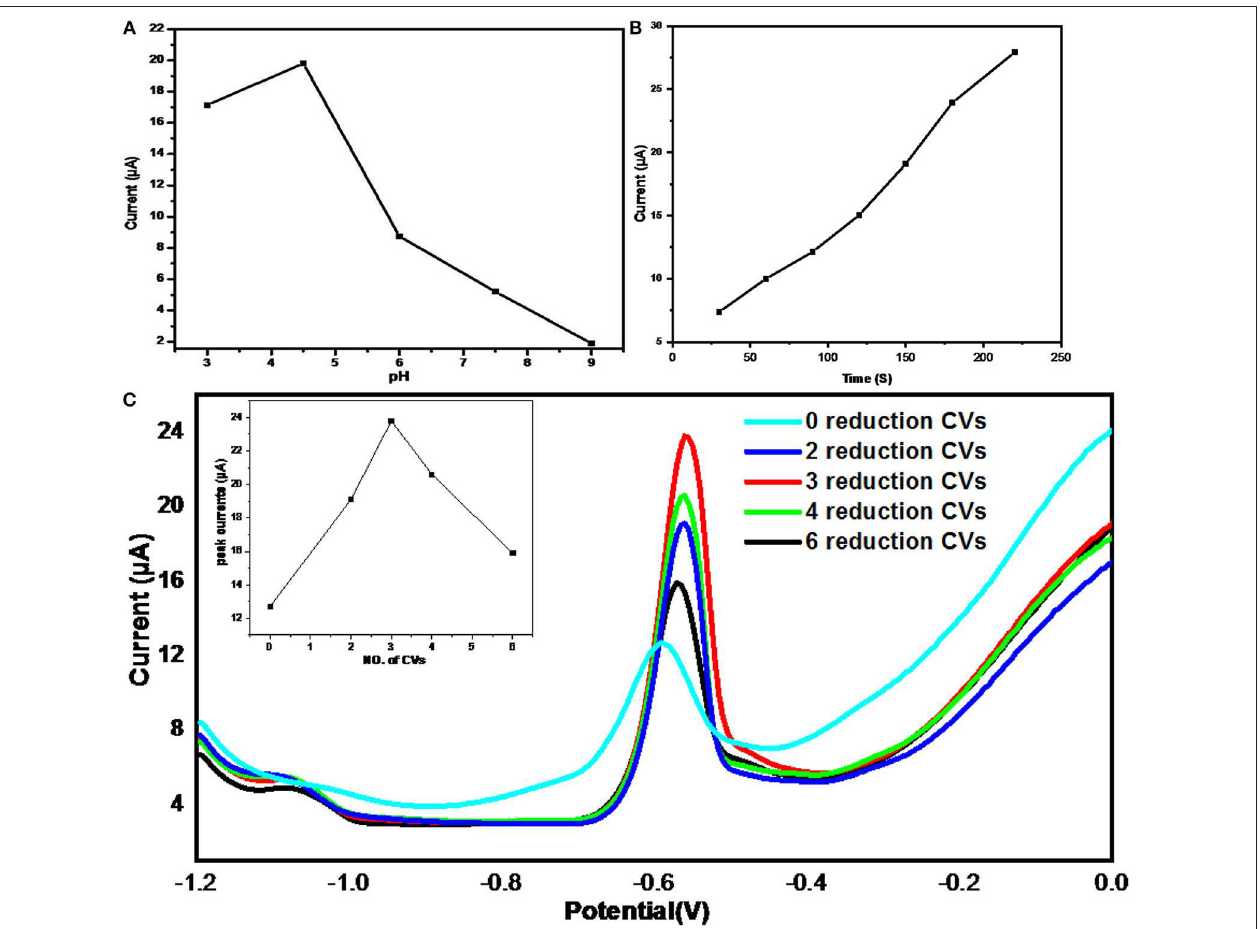
FIGURE 8 | The effects of (A) solution pH, (B) accumulation time, and (C) Electrochemical reduction degrees; (inset shows the peak currents vs. No. of CVs); on the stripping currents of Pb 2 + ions from ErGO–MWNTs–L-cys/GCEs in 0.1M HAc-NaAc buffer solution containing 40 µ gL − 1 of Pb 2 + saturated with nitrogen gas under optimal